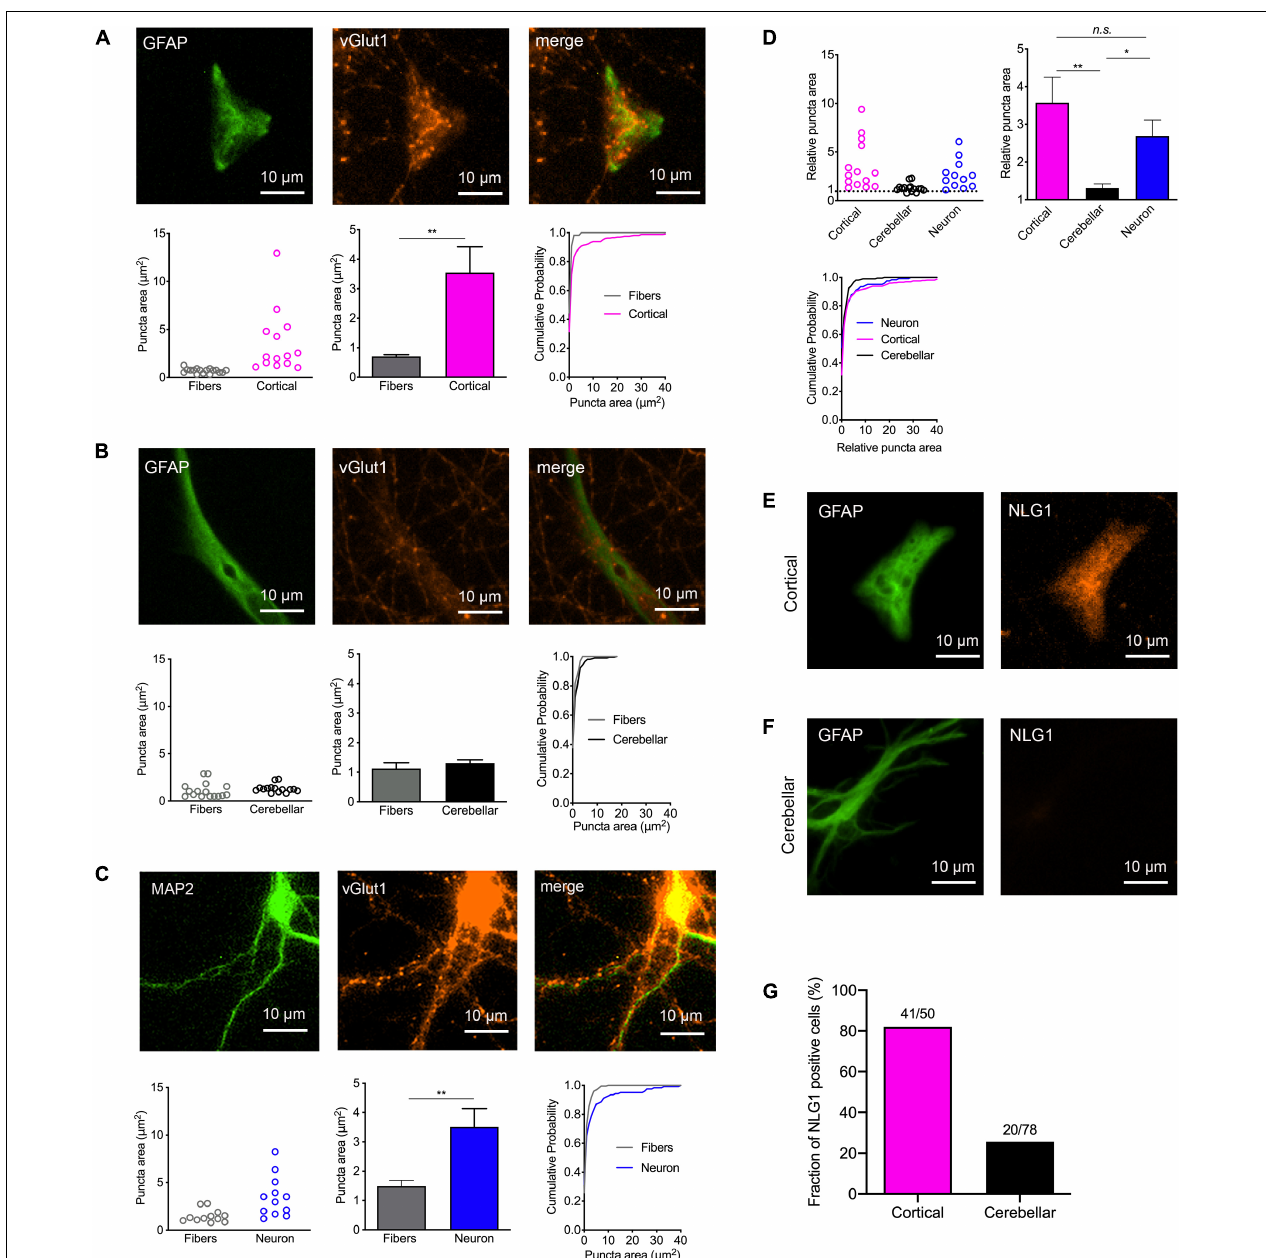
FIGURE 2 | Induction of synaptic vesicle clusters in axons by immature cortical astrocytes. (A–D) Immunostaining for vGlut1 revealed induction of vesicle clusters in axons by target cells. (A) Upper panel: Immunostaining of immature cortical astrocytes for GFAP (left image), vGlut1 (middle image), and merge image. Lower panel: Quantification of vesicle cluster area [left: means of individual cells ( n = 14/14); middle: means of cells ± SEM; right: cumulative distribution of the areas of all puncta (110/326)]. (B) Upper panel: Immunostaining of cerebellar astrocytes for GFAP (left image), vGlut1 (middle image), and merge image. Lower panel: Quantification of vesicle cluster (vGlut1 puncta) area [left: means of individual cells ( n = 15/15); middle: means of cells ± SEM; right: cumulative distribution of the areas of all puncta (66/211)]. (C) Upper panel: Immunostaining of control neurons for MAP2 (left image), vGlut1 (middle image), and merge image. Lower panel: Quantification of vesicle cluster area [left: means of individual cells ( n = 12/12); middle: means of cells ± SEM; right: cumulative distribution of the areas of all puncta (224/124)]. ** P < 0.01, Student (cid:48) s t -test. (D) Direct quantitative comparison of relative vGlut1 puncta area [normalized to respective mean puncta area in non-contacting axons (fibers)] in immature cortical astrocytes, in cerebellar astrocytes, and in control neurons. Upper left: means of individual cells; upper right: means of cells ± SEM; lower left: cumulative distribution of the areas of all puncta. * P < 0.05, ** P < 0.01, one-way-ANOVA with Tuckey’s post-hoc test. (E–G) Immunostainings for GFAP (left image) and Neuroligin1 (NLG1) in immature cortical astrocytes (E) and in cerebellar astrocytes (F) as target cells. Note the prominent expression of Neuroligin1 in immature cortical astrocytes. (G) Quantification of the fraction of Neuroligin1 expressing cortical and cerebellar astrocytes.